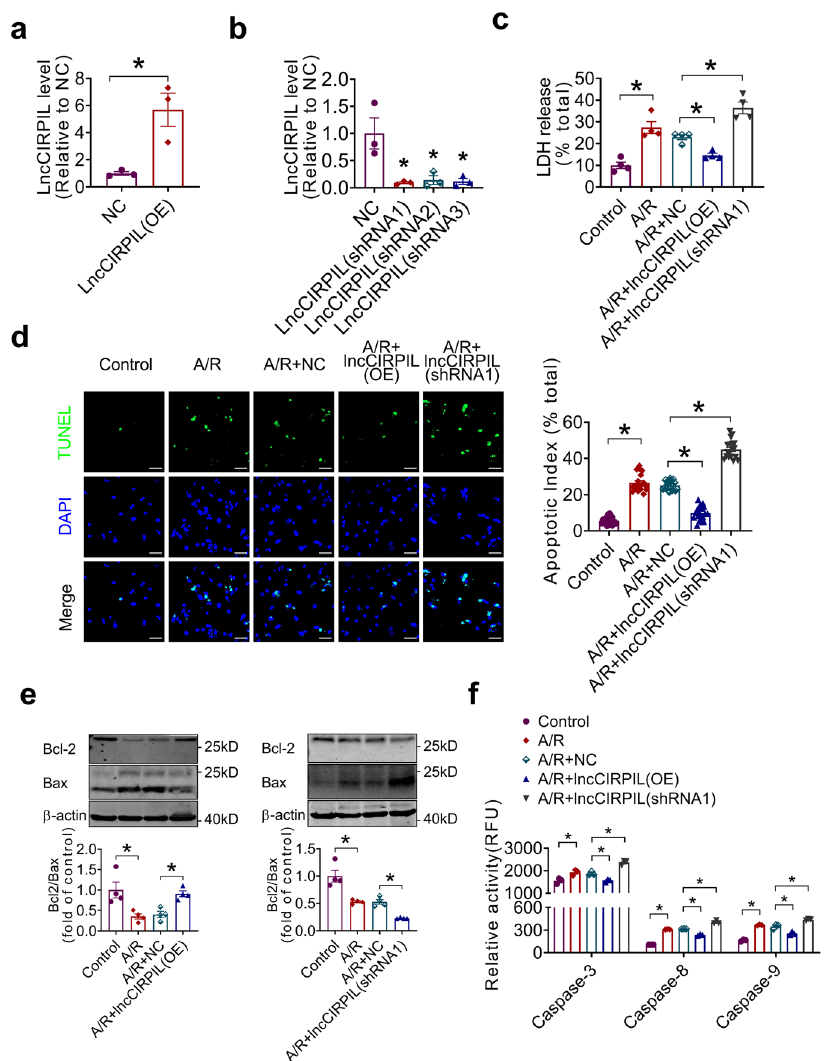
Fig. 2 Effects of lncCIRPIL on anoxia/reoxygenation(A/R) induced injury of NMCMs. a Validation of lncCIRPIL overexpression plasmid in NMCMs. n = 3. * P < 0.05 vs NC (negative control) by two-tailed Student ’ s t test. b Knockdown ef fi ciency of shRNAs for lncCIRPIL in NMCMs. n = 3. * P < 0.05 vs NC by two-tailed Student ’ s t test. c Effects of lncCIRPIL on LDH release of NMCMs subjected to A/R insult. n = 4. * P < 0.05 by one-way ANOVA followed